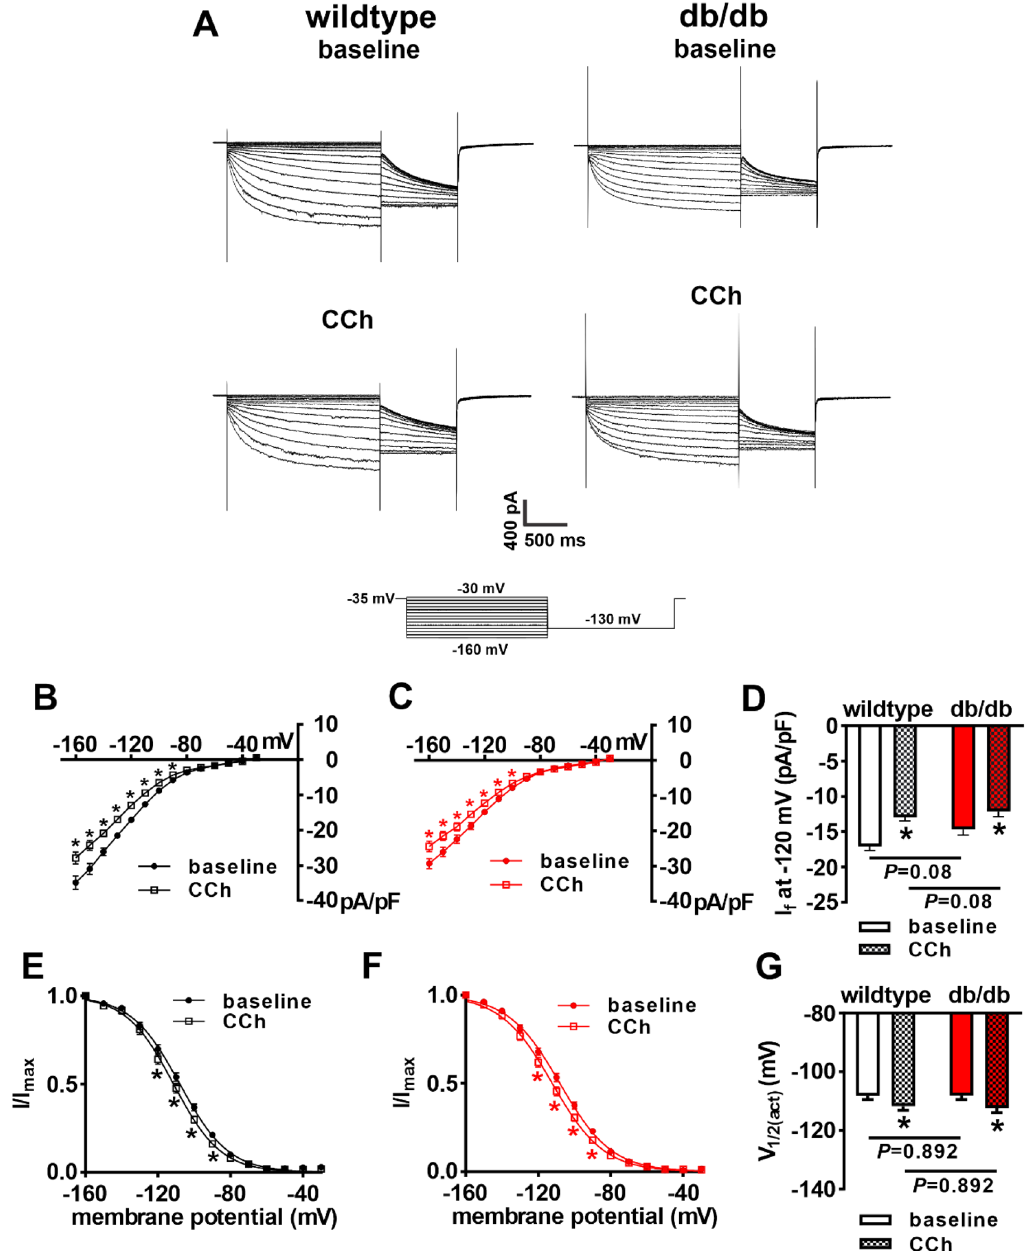
Figure 5. Effects of carbachol on the hyperpolarization-activated current (I f ) in db/db SAN myocytes. ( A ) Representative I f recordings at baseline and after CCh (10 µM) application in wildtype and db/db SAN myocytes. Voltage clamp protocol shown at bottom of recordings. ( B ) I f IV curves at baseline and after CCh application in wildtype SAN myocytes ( n = 15). ( C ) I f IV curves at baseline and after CCh application in db/db SAN myocytes ( n = 16). For panels ( B ) and ( C ) * P < 0.05 vs. baseline by two-way repeated measures ANOVA with Holm–Sidak posthoc test. ( D ) I f density at − 120 mV at baseline and after CCh application in wildtype and db/db SAN myocytes. * P < 0.05 vs baseline by two-way ANOVA with Holm–Sidak posthoc test. ( E ) I f steady- state activation curves at baseline and after CCh application in wildtype SAN myocytes ( n = 15). ( F ) I f steady- state activation curves at baseline and after CCh application in db/db SAN myocytes ( n = 16). ( G ) I f V 1/2(act) at baseline and after CCh application in wildtype and db/db SAN myocytes. * P < 0.05 vs. baseline by two-way ANOVA with Holm–Sidak posthoc test. Refer to Supplementary Table 1 for additional analysis of I f steady-state